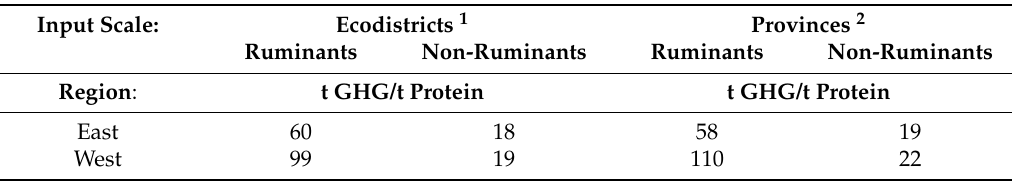
Table 4. A comparison of the GHG-protein indicator generated at the ED scale and at the provincial scale for ruminant and non-ruminant livestock for 2006.